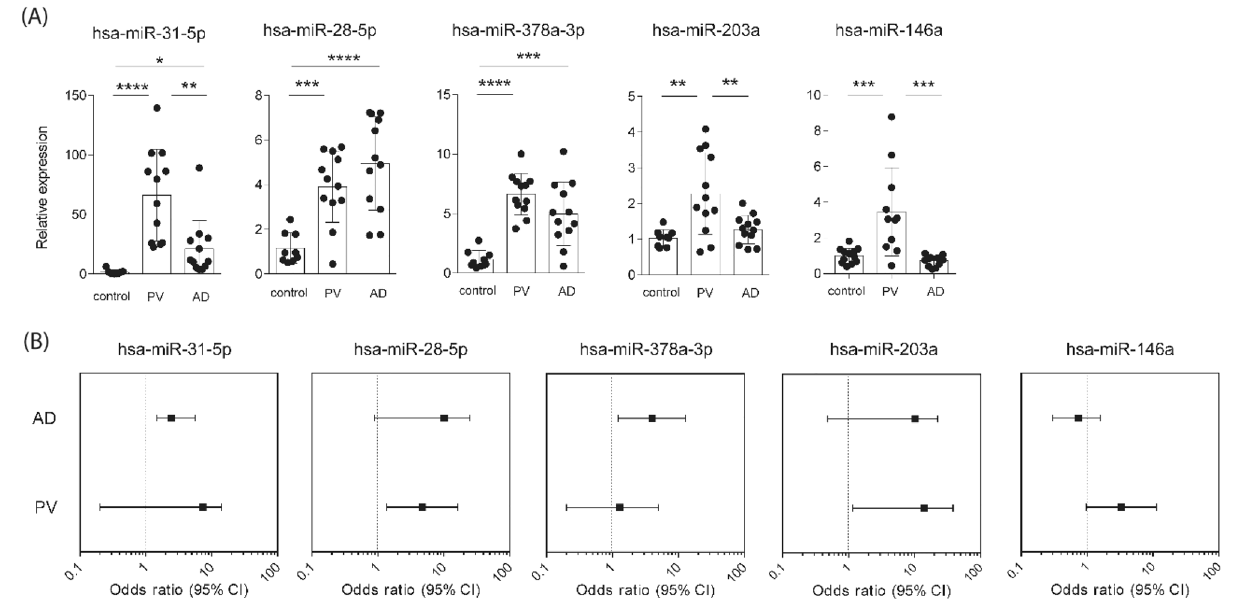
Figure 2. Skin miRNAs as predictive markers of AD and PV. ( A ) miR-31-5p, miR-28-5p, miR-378a-3p, miR-203a and miR-146a relative expression of control, PV and AD serum samples from the validation cohort assessed by RT-qPCR analysis. Data are represented as mean with SD and ANOVA (post hoc test) * p ˂ 0.05, ** p ˂ 0.01, *** p ˂ 0.001 and **** p ˂ 0.0001. ( B ) Forest plot showing Odds ratio (OR) and 95% confidence interval (CI) of miR-31-5p, miR-28-5p, miR-378a-3p, miR-203a and miR-146a for AD and PV assessed by logistic binary 1.35–16.33; p ˂ 0.05) and high levels of miR-203a (OR = 13.93; 95% confidence interval 1.15–38.45; p ˂ 0.05) were indicators of PV (Fig. 2B). Finally, levels of miR-146a did not predict the manifestation of AD or PV (Fig. 2B). In conclusion, miRNA profiling results of skin biopsies from AD and PV patients revealed highly similar expression pattern between the two diseases as compared to controls.